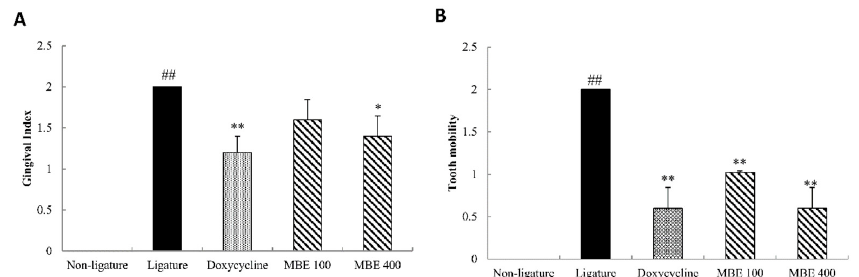
Figure 2. Effects of MBE on Gingival Index and Tooth mobility. The gingival index ( A ) and tooth